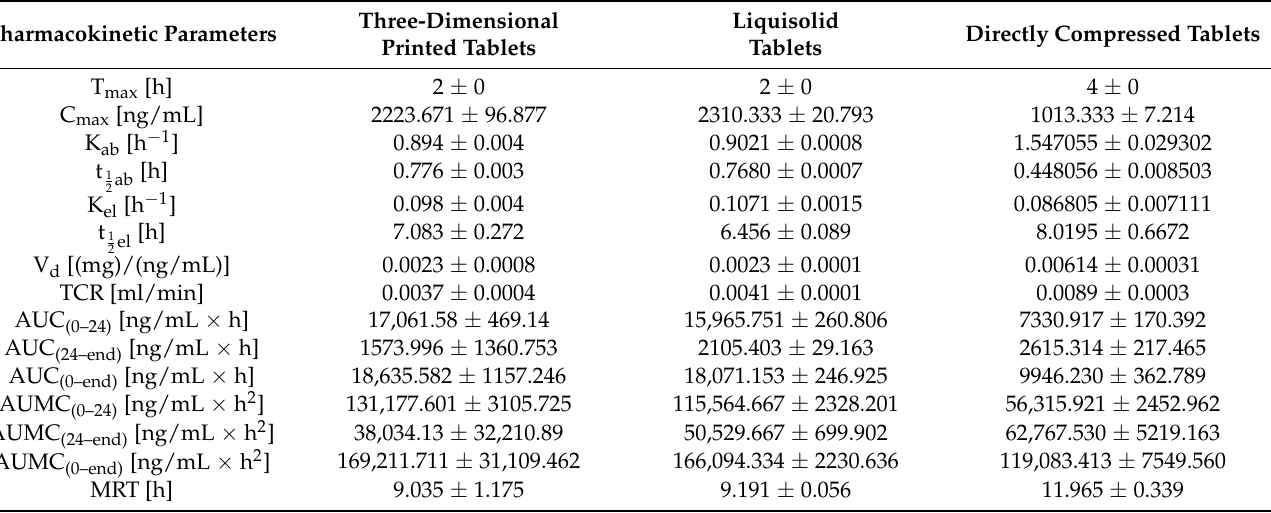
Figure 4. The plasma concentration versus time profile of glimepiride following the oral administra- tion of the prepared tablets to Male Wistar rats. (Mean ± SD, n = 6). Table 2. Pharmacokinetic parameters of glimepiride following oral administration of the studied tablets to Male Wistar rats ( n =